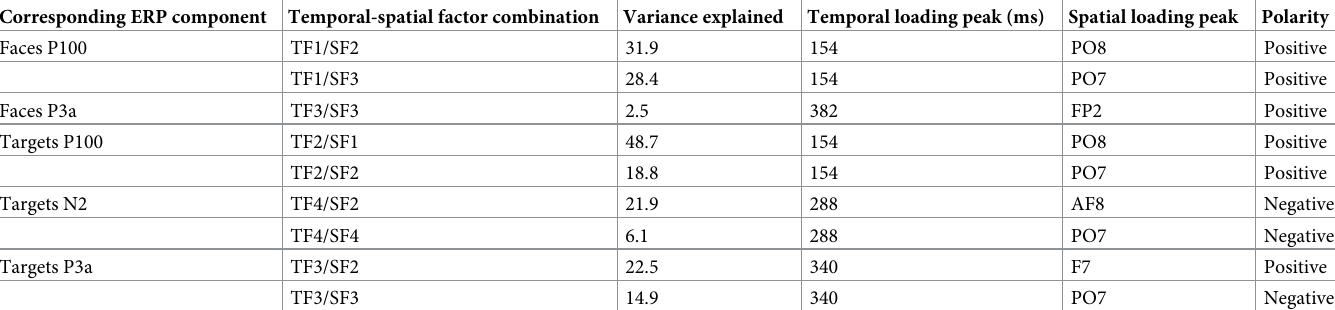
(1.0, 30.0) = 5.41; p = .029], showing WJT/C (1.0, 20.1) = 6.12; p = .025], WJT/C